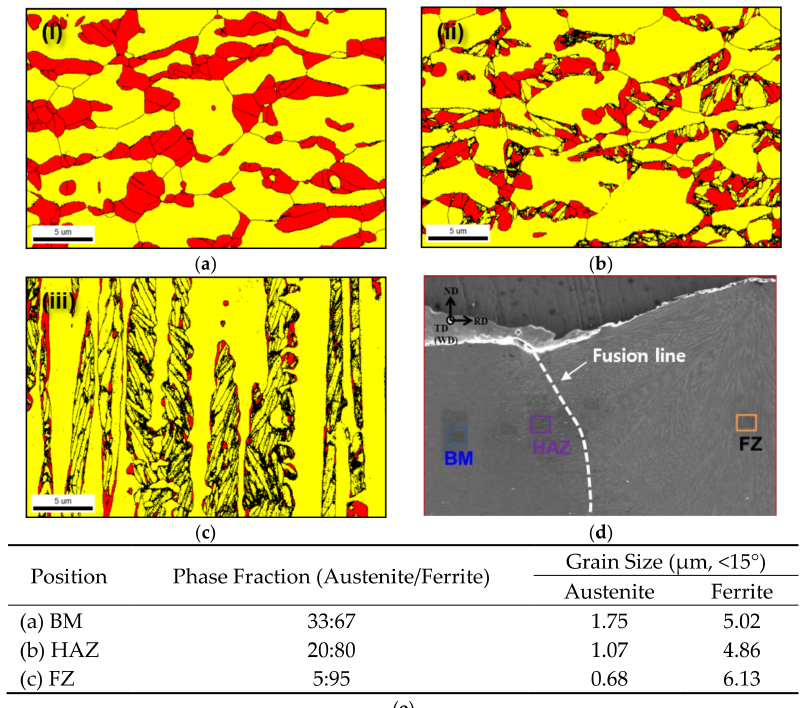
Figure 6. EBSD phase maps of laser-welded medium-Mn-content steel ( (cid:4) BCC; (cid:4) FCC; misorientation angle > 10 ◦ ): ( a ) base metal; ( b ) heat-affected zone; ( c ) fusion zone; ( d ) definition of welds and Electron backscatter diffraction (EBSD) measuring points; ( e ) Measured phase fraction and average grain size of each region. Laser welds were fabricated at a laser power of 3 kW and a welding speed of 8 m/min using a 450-mm focusing optic